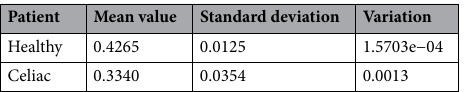
Table 5. Interpretation of the average variation of red spectrum.